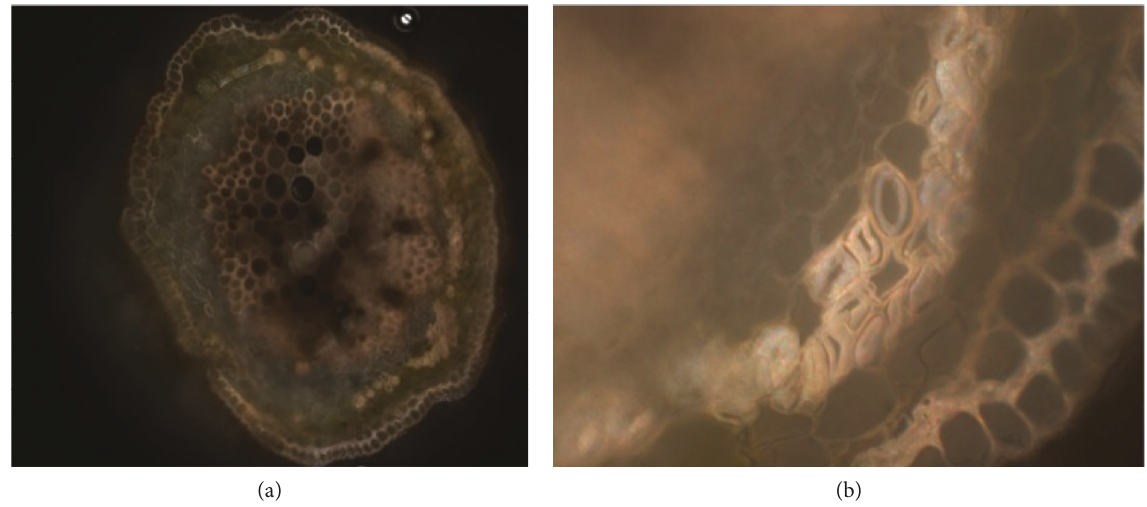
Figure 2: A modi fi ed picture from [17]. (a) Cross-sectional area of a Passi fl ora tendril; (b) magni fi cation of the lateral wall of the tendril section. The G-cells can be distinguished from the remaining plant body through the thick delineation of their oval cell